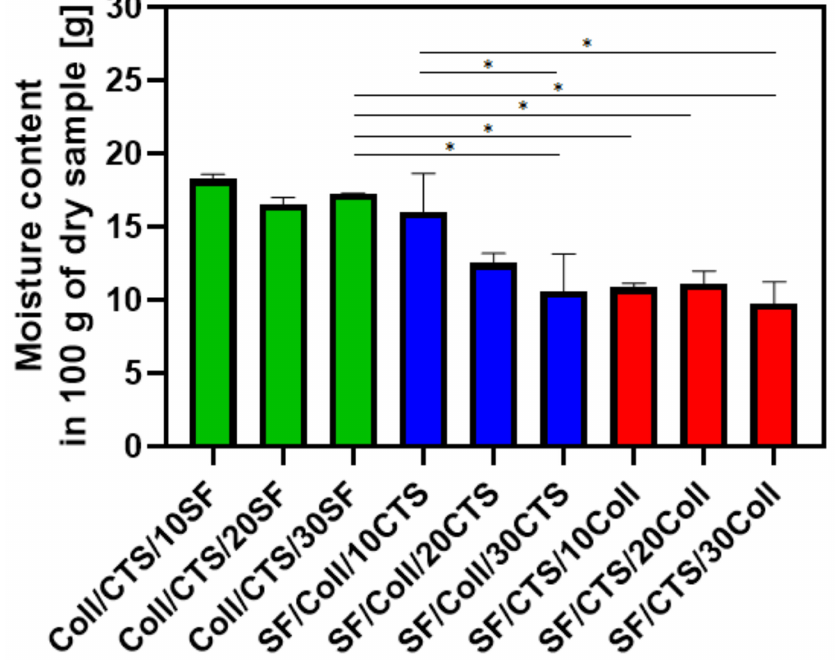
Figure 7. The result of moisture content measurements of biopolymeric three-component scaf- folds cross-linked by EDC/NHS; *—represents statistically significant differences between samples ( p ≤